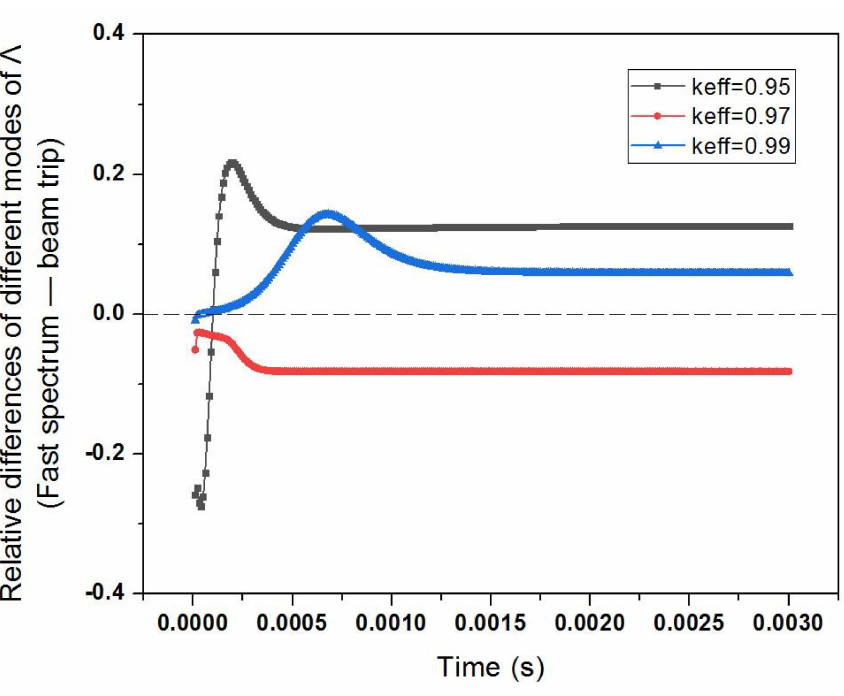
Figure 5. Relative differences in Λ with time for different modes of the fast spectrum, under different subcriticalities and beam trips.